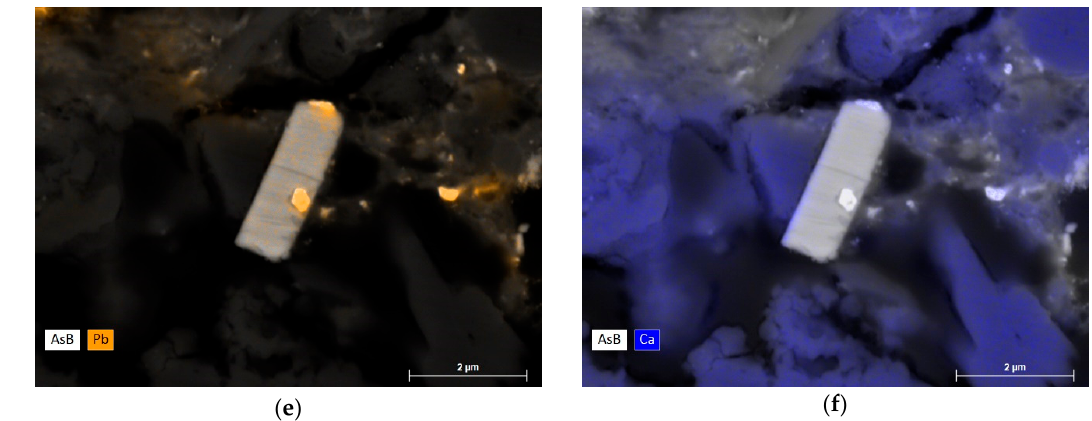
Figure 5. ( a ) Angle selective backscattered electron image of the Cu-Ni–Sb particle in sample Ch35—quantitative measure- ment no. Ch35/1; ( b – f ) X-ray intensity maps of selected elements in malachite layer:( b ) Cu map; ( c ) Ni map; ( d ) Sb map; ( e ) Pb map; ( f ) Ca map.